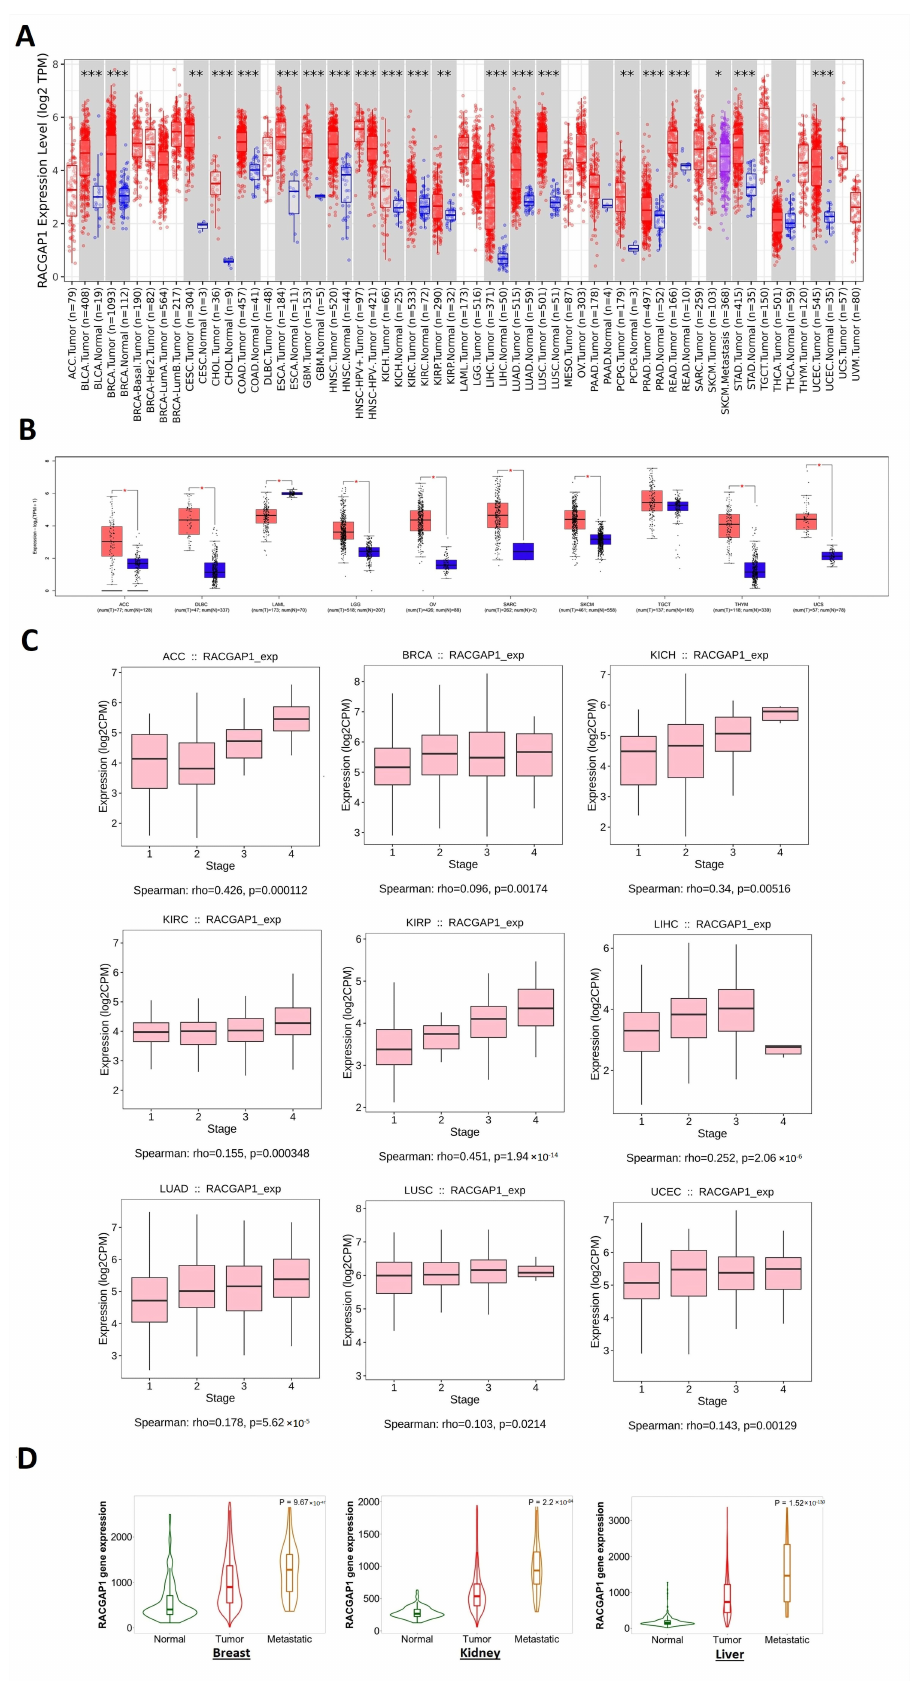
Figure 1. RACGAP1 expression assessment in human cancers. ( A ) Differential expression of